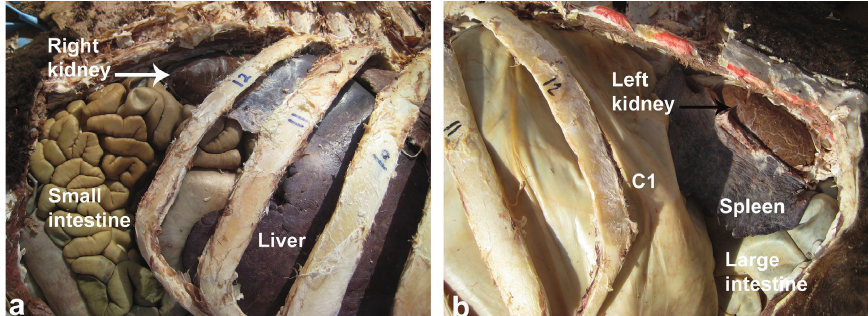
Figure 3: Anatomical position of the right (white arrow) (a) and left (black arrow) (b) kidneys in a camel carcass preserved with 10% formalin solution. C 1 � first gastric compartment.